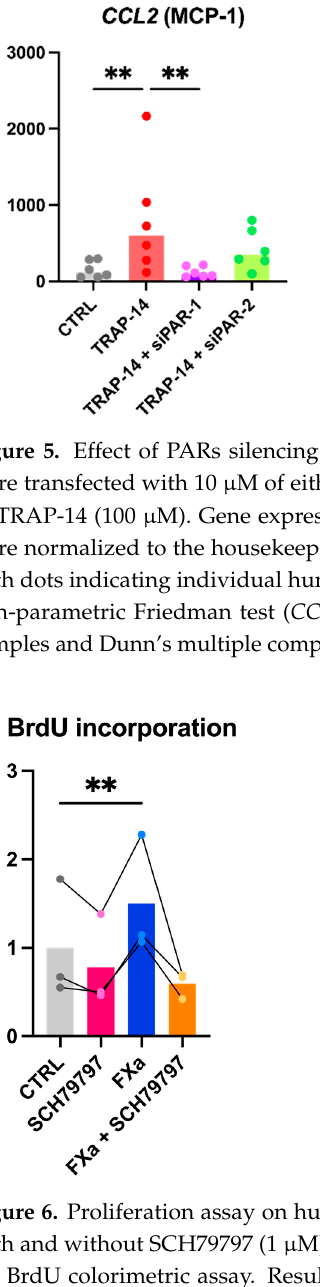
Figure 6. Proliferation assay on human atrial CFs ( n = 3). Cells were incubated with 100 nM FXa with and without SCH79797 (1 µ M). Proliferation was measured 24 h after exposure to the stimuli via BrdU colorimetric assay. Results are expressed as fold-change relative to CTRL (mean bars). Statistical analysis was performed using the repeated measures one-way ANOVA ( p < 0.01) and Šid á k’s multiple comparison test (** p < 0.01). Lines depict paired data points.